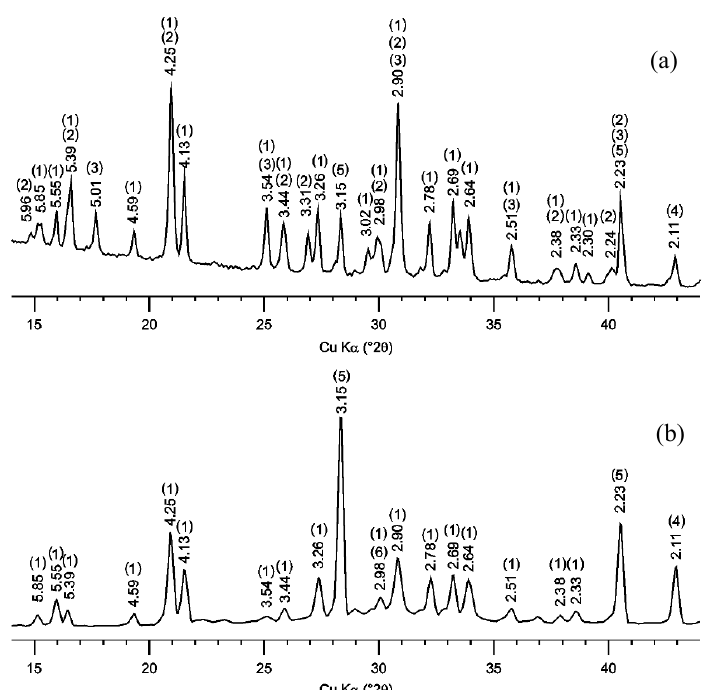
Figure 1. X-ray diffraction patterns of a compound containing (a) CsCl and (b) LiCl-KCl-CsCl. Figure 1. X-ray di ff raction patterns of a compound containing ( a ) CsCl and ( b )